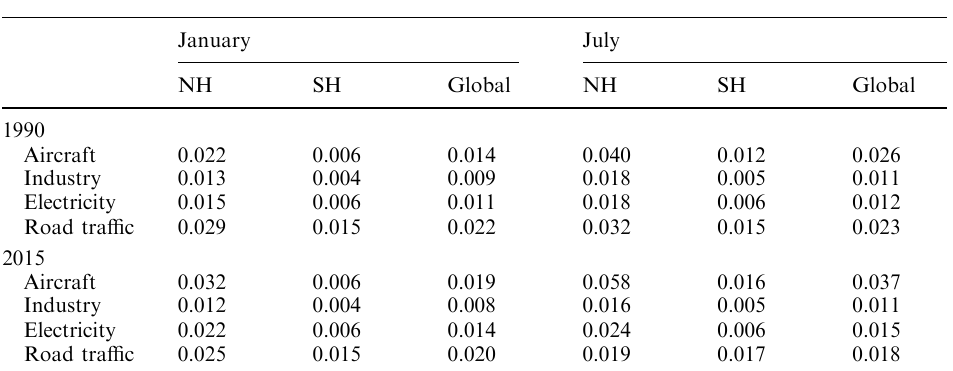
Table 4. Contribution to the radiative forcing by ozone cha- nges due to the di(cid:128)erent anthropogenic NO sources for x 1990 and 2015 calculated with the radiation model (MacKay and Khalil, 1991). The average values for the Northern- and Southern Hemisphere and the global average value are given for January and July in W m )